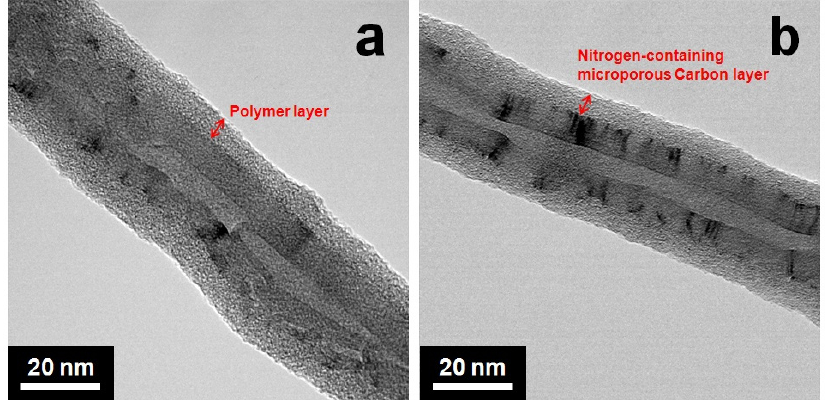
Figure 1. TEM images of ( a ) polymer-coated carbon nanotubes (CNTs); and ( b ) nitrogen- and micropore-containing CNTs